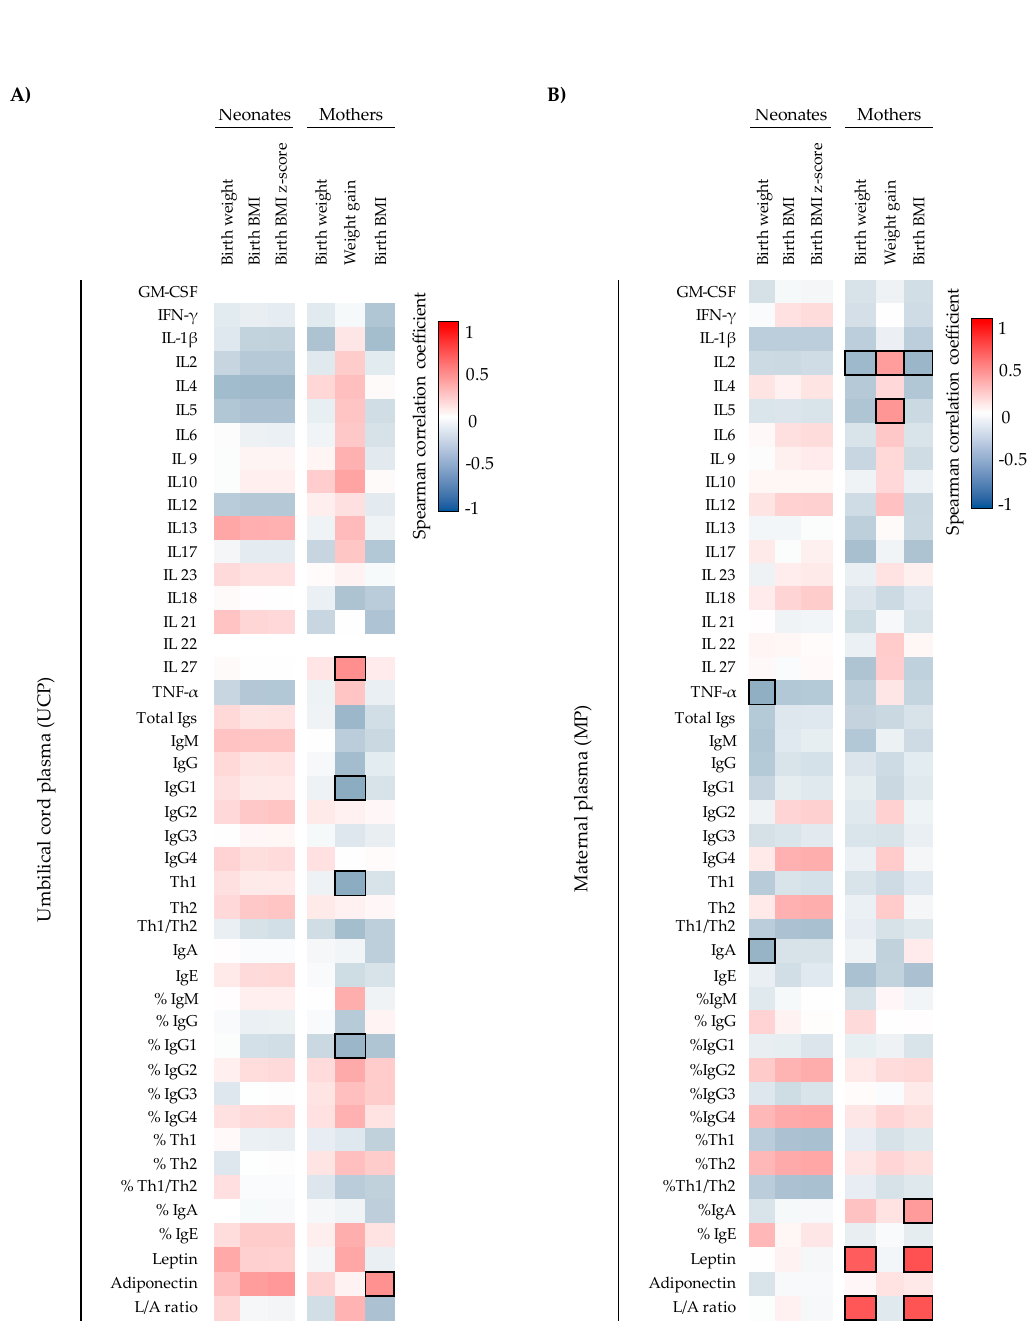
Figure 3. Correlations between CK, Ig, and adipokine composition present in UCP ( A ) ( n = 23) and MP ( B ) ( n = 26) with the maternal and infant weight parameters. The Spearman correlation coefficient is represented in the heatmap following the color in the legend. Bold frames represent correlations with statistical significance ( p < 0.05). MP, maternal plasma; UCP, umbilical cord plasma; GM-CSF, Granulocyte Macrophage Colony-Stimulating Factor; IFN, Interferon; IL, Interleukin; L/A ratio, Leptin/Adiponectin ratio; TNF, tumor necrosis factor. IgG1, IgG2, and IgG3 (Igs associated with Th1 response); IgG4 (Ig associated with Th2 response) [30,31].